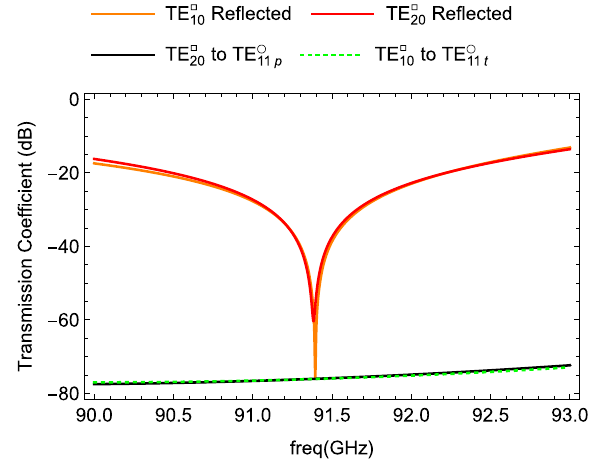
polarization.FIG. 24. Cylindrical TE ○ 11 to rectangular TE □ 10 = TE □ 20 mode converter with chokes s-parameters vs